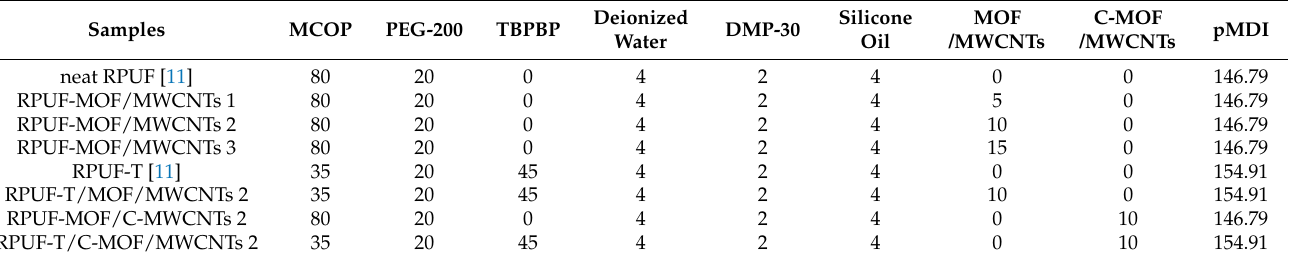
Table 1. The formulation of bio-based